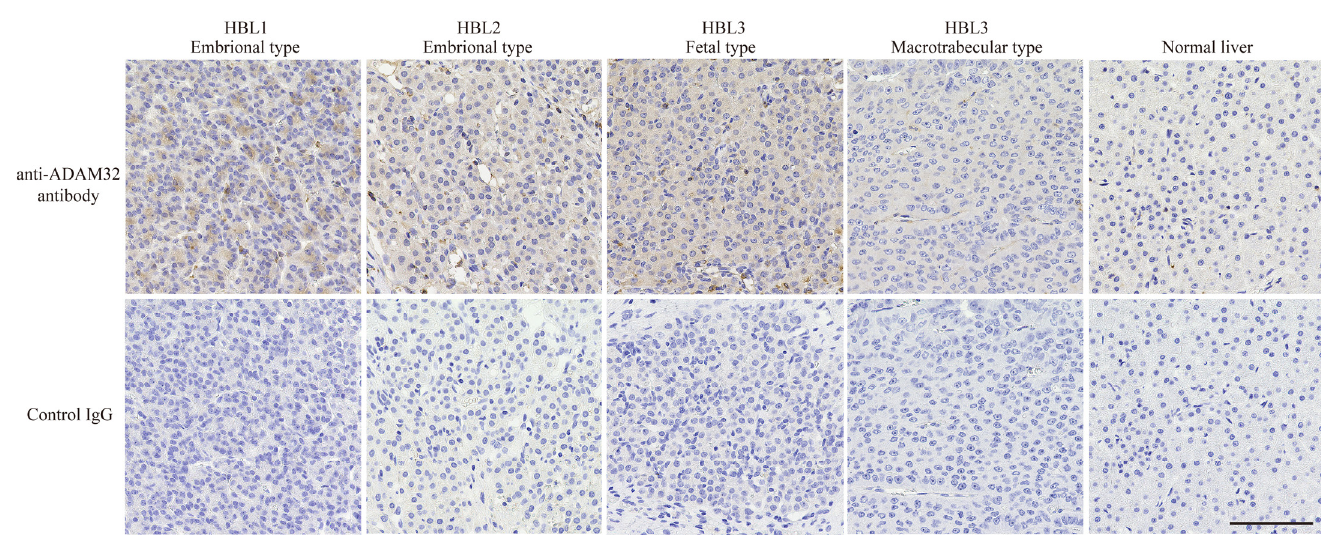
Figure 1. ADAM32 was expressed at high levels in embryonal and fetal subtypes of HBL. Expression of ADAM32 was evaluated with IHC using anti-ADAM32 antibody ( top ), and normal rabbit IgG as control ( bottom ) in the section of HBL subtypes. Results with normal liver tissue are shown on the far right. Representative images are shown. Scale bar = 100 μ m. far right. Representative images are shown. Scale bar = 100 µ